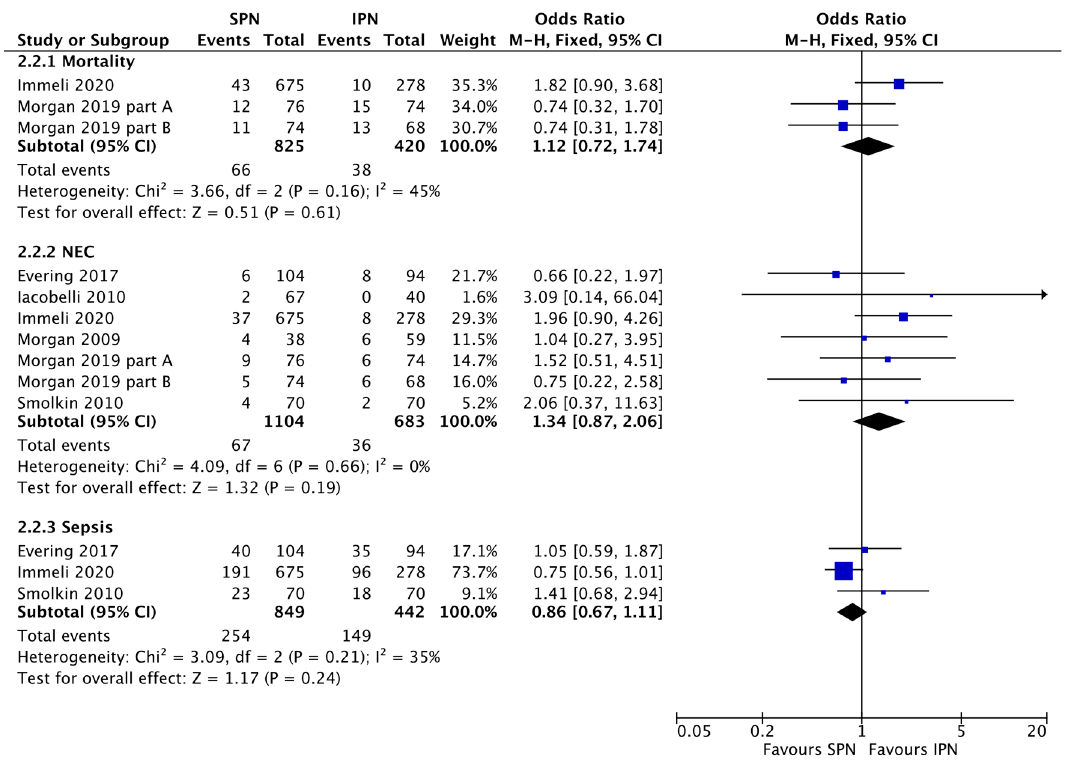
Figure 3. Forest plot on the effect of standardized parenteral nutrition (SPN) vs. individualized parenteral nutrition (IPN) on mortality, necrotizing enterocolitis (NEC) incidence, and sepsis incidence. Blue squares represent individual studies, diamonds represent subgroup analyses.